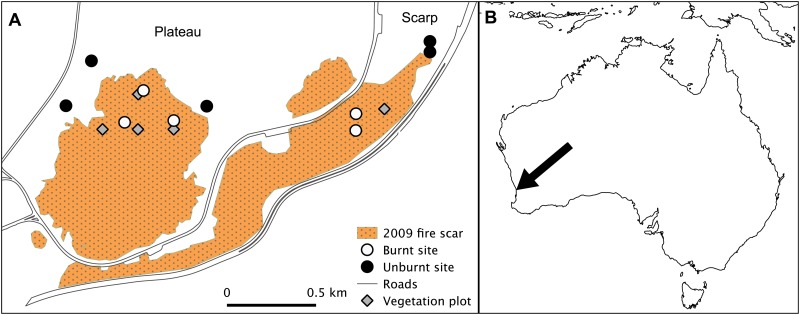
Location of monitoring sites at Kings Park (A) and study site location in south-western Australia (B).